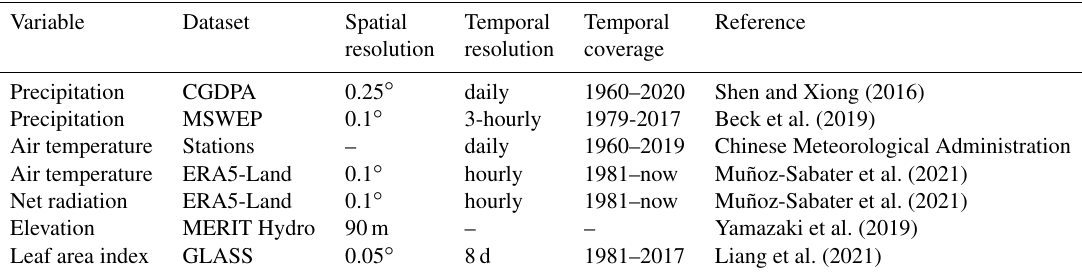
Table 1. Sources of forcing and auxiliary data.